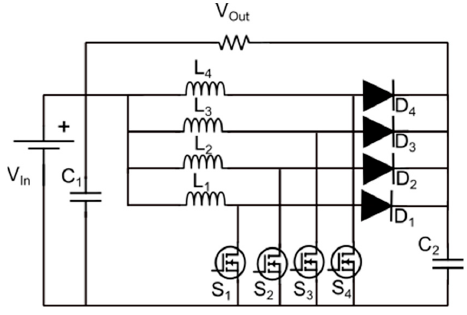
Figure 11. Four-phase interleaved buck-boost converter (4PIBb).